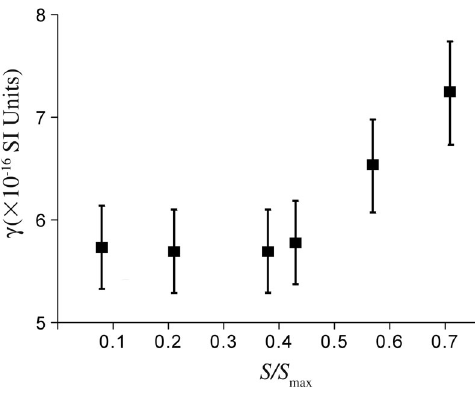
Fig. 5. Normalized experimental stress-strain dia- gram from a Penteli marble